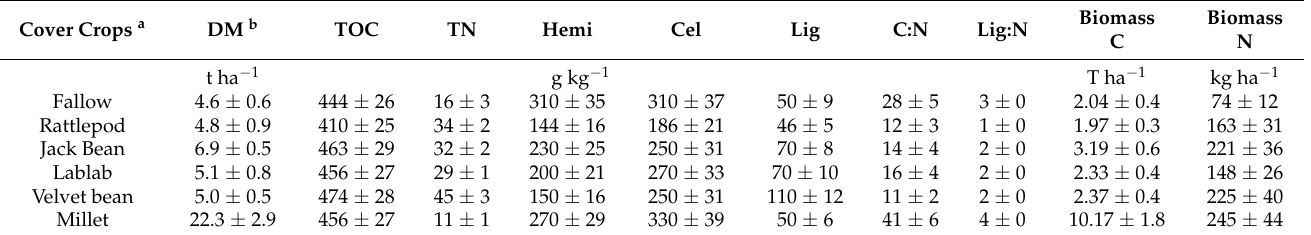
Table 2. Dry matter yield and composition of cover crops species used in experiment. Results from the 2012/2013 growing season (mean ± standard